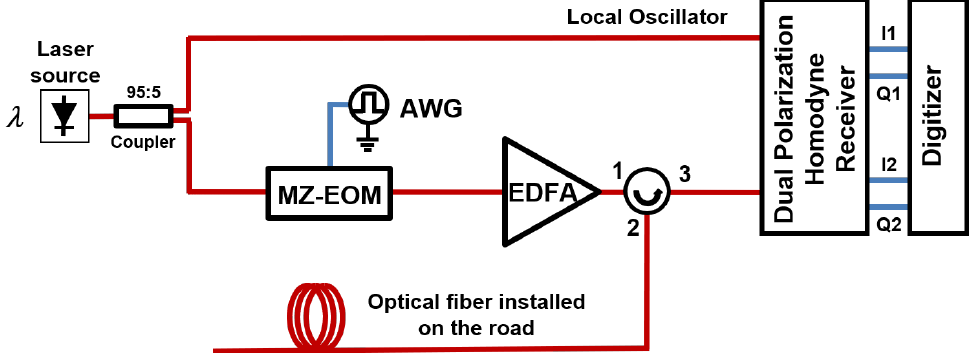
Figure 2. Experimental setup of an OPC-COTDR DAS